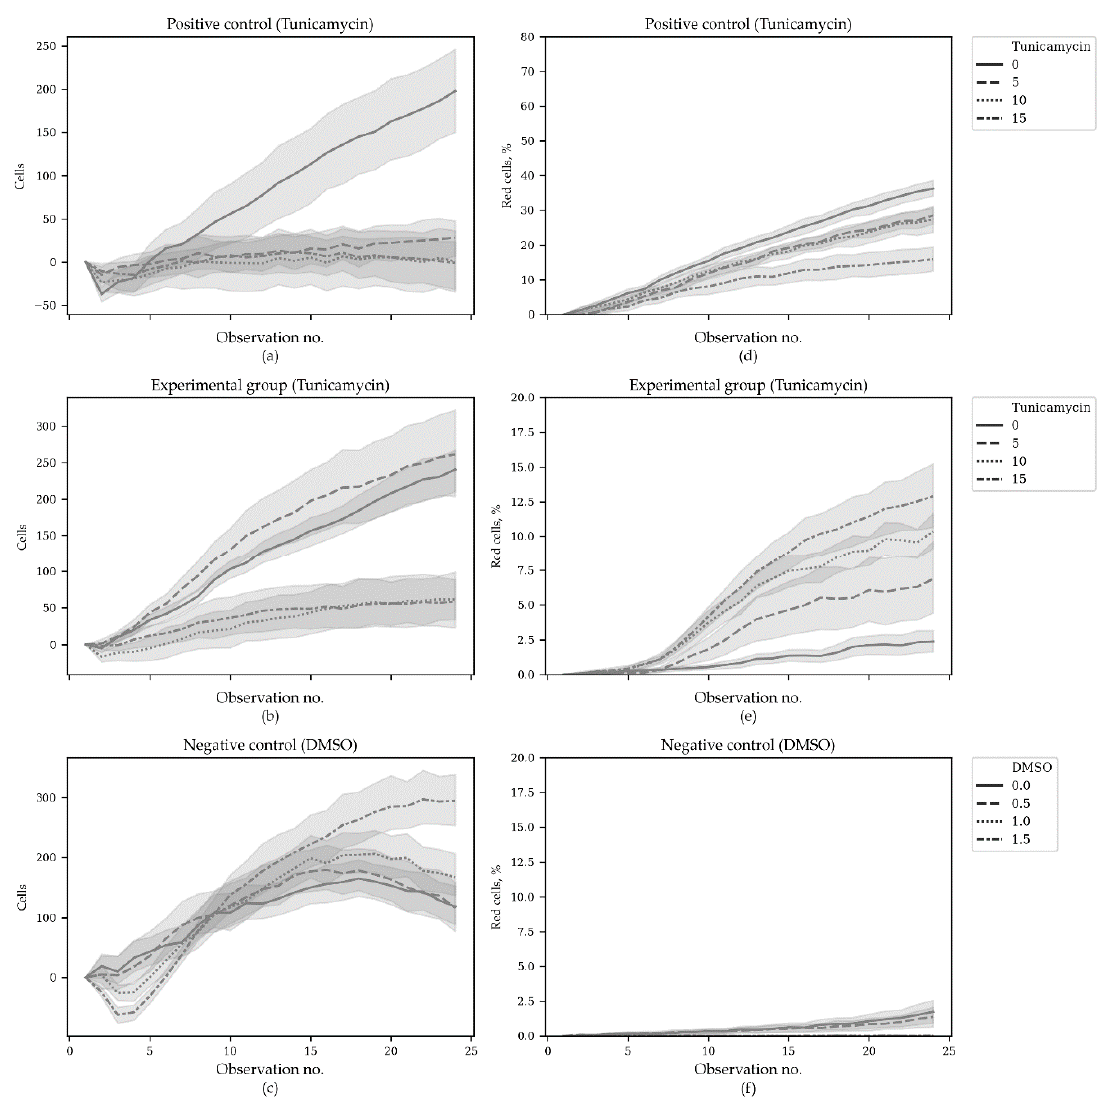
Figure 5. Cell counts and red cells percentage changes during the second ER stress time course experiment. In total, 5208 microscopic images were analyzed. Positive control—a group of cells that constantly expressed TagRFP; experimental group—the cells with TagRFP expression induced under ER stress conditions. These two groups were treated with different tunicamycin concentrations (µg/ml). Negative control group—the ER-responsive cells treated with different DMSO concentrations (%). Panels ( a ), ( b ) and ( c ) show the cell count change throughout the time course and panels ( d ), ( e ) and ( f )—the change of red cells percentage. N = 18. The horizontal axes correspond to observation number.